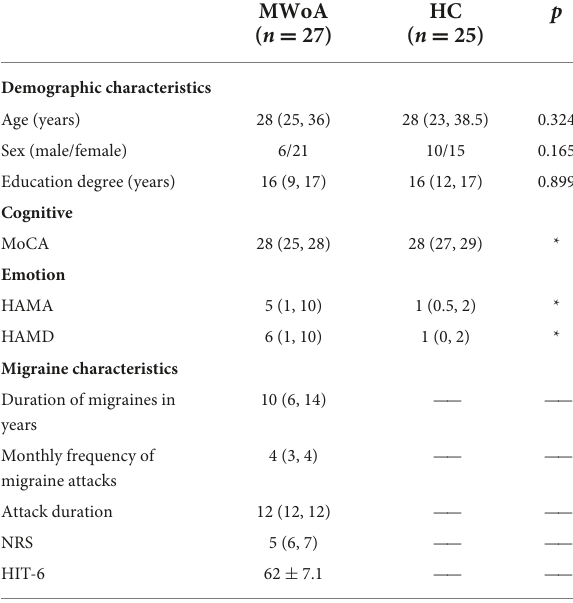
TABLE 1 General demographic information of